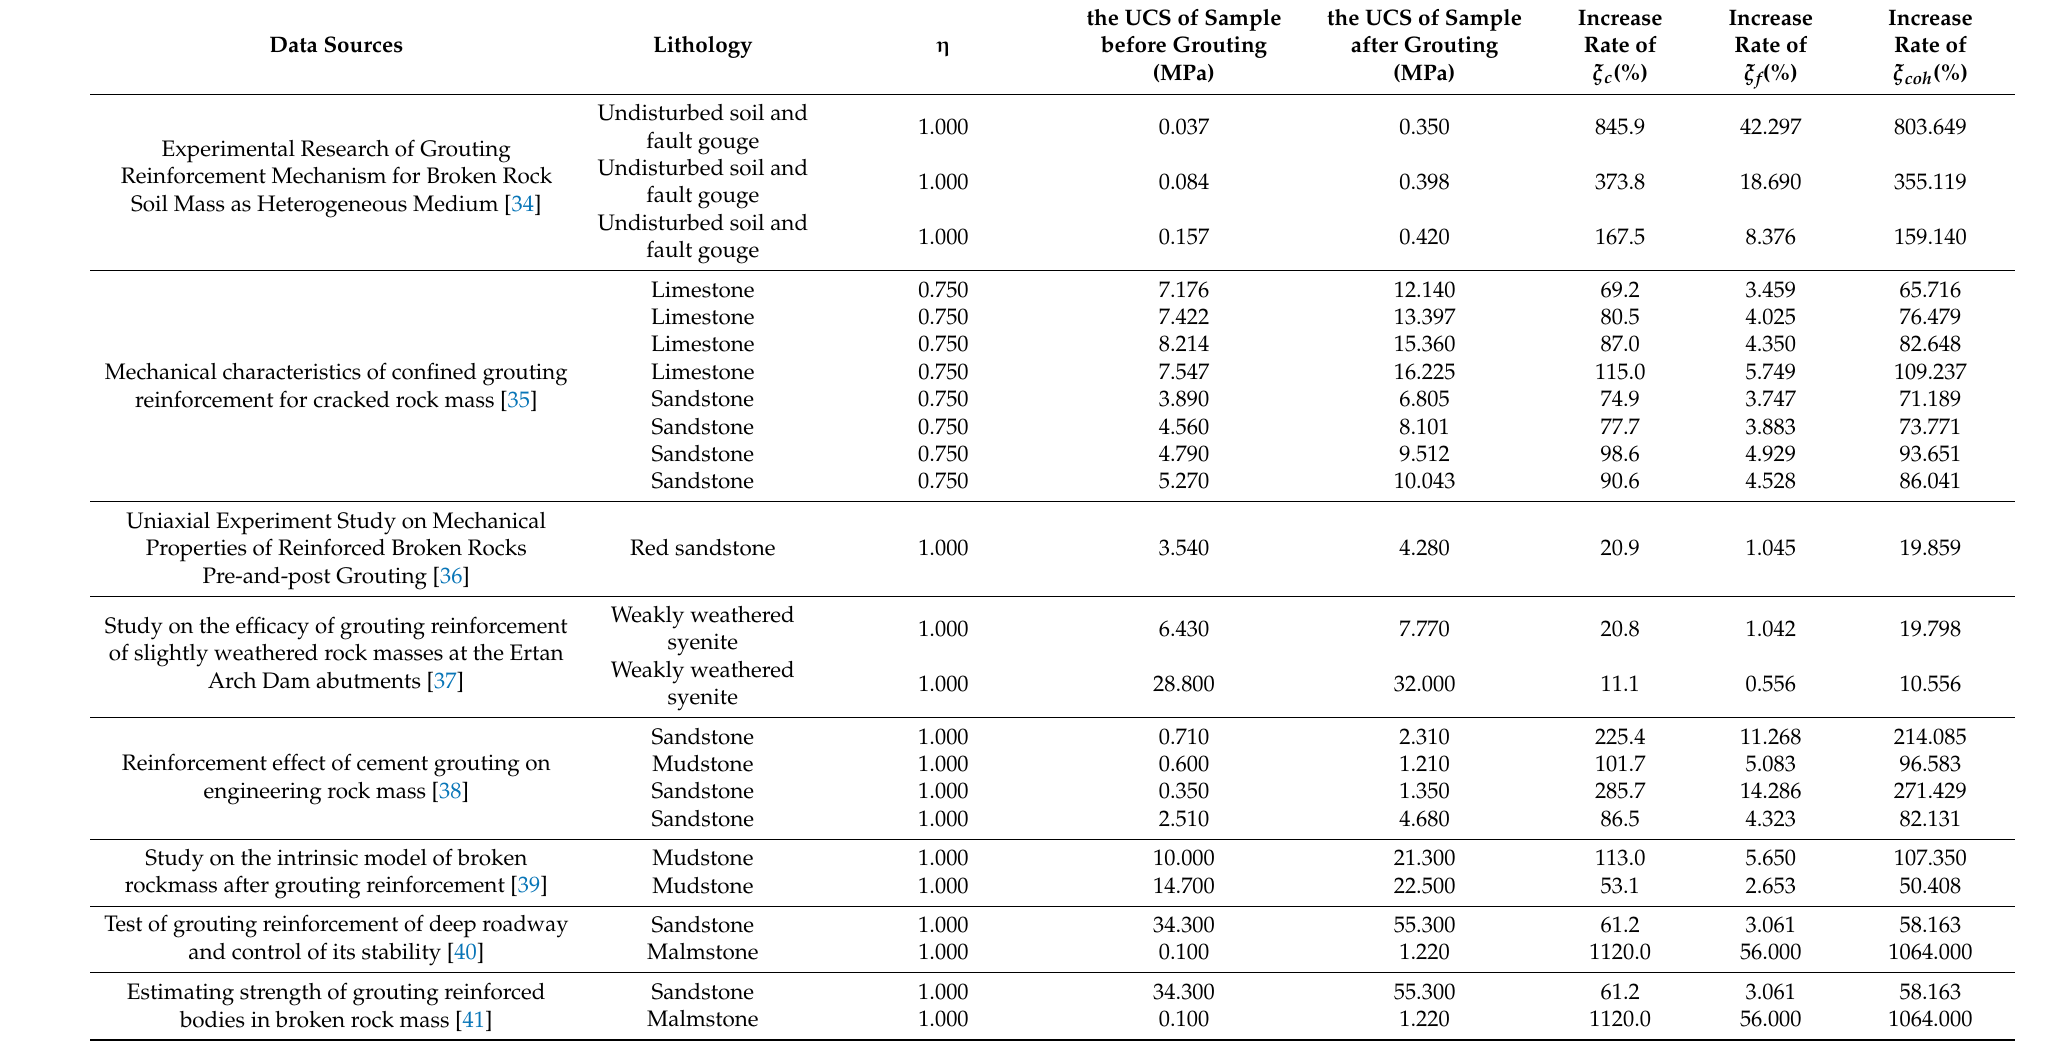
Table 1. Compressive and shear strength of rock mass before and after